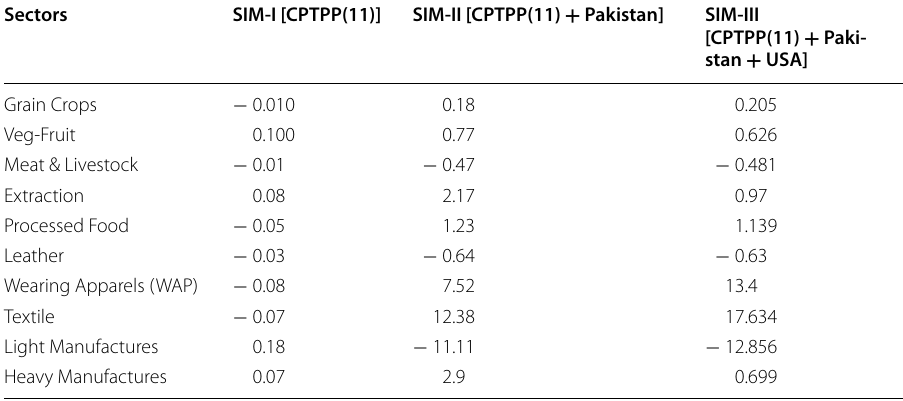
Table 4 Impact of CPTPP on sectorial output of Pakistan Source : Author’s simulation